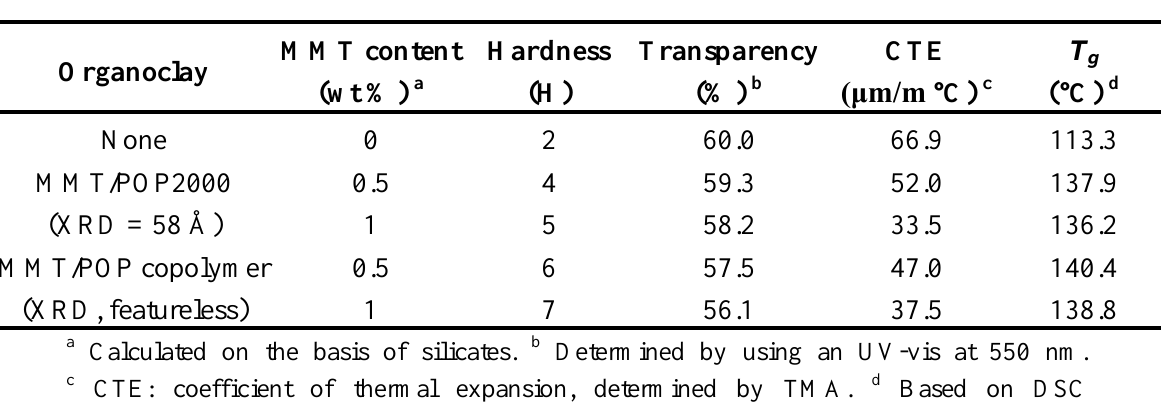
Table 1. Properties of melamine-novalac cured epoxies with the organo-MMT (reprinted with permission from reference